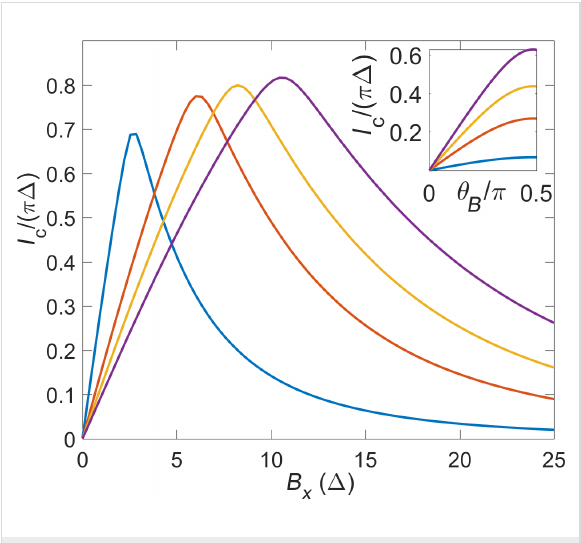
Figure 5: Main panel: Mean-field results for the critical current I c vs local magnetic field scale B x in S–QD–TS junctions. Parameters are as in the main panel of Figure 4, i.e., U = 10 Δ , ε 0 = − U /2, and B y,z = 0. From left to right, different curves are for Γ / Δ = 4.5, 8, 10 and 12.5. Inset: I c vs angle θ B , where B = B (sin θ B ,0,cos θ B ) with B = 15 Δ